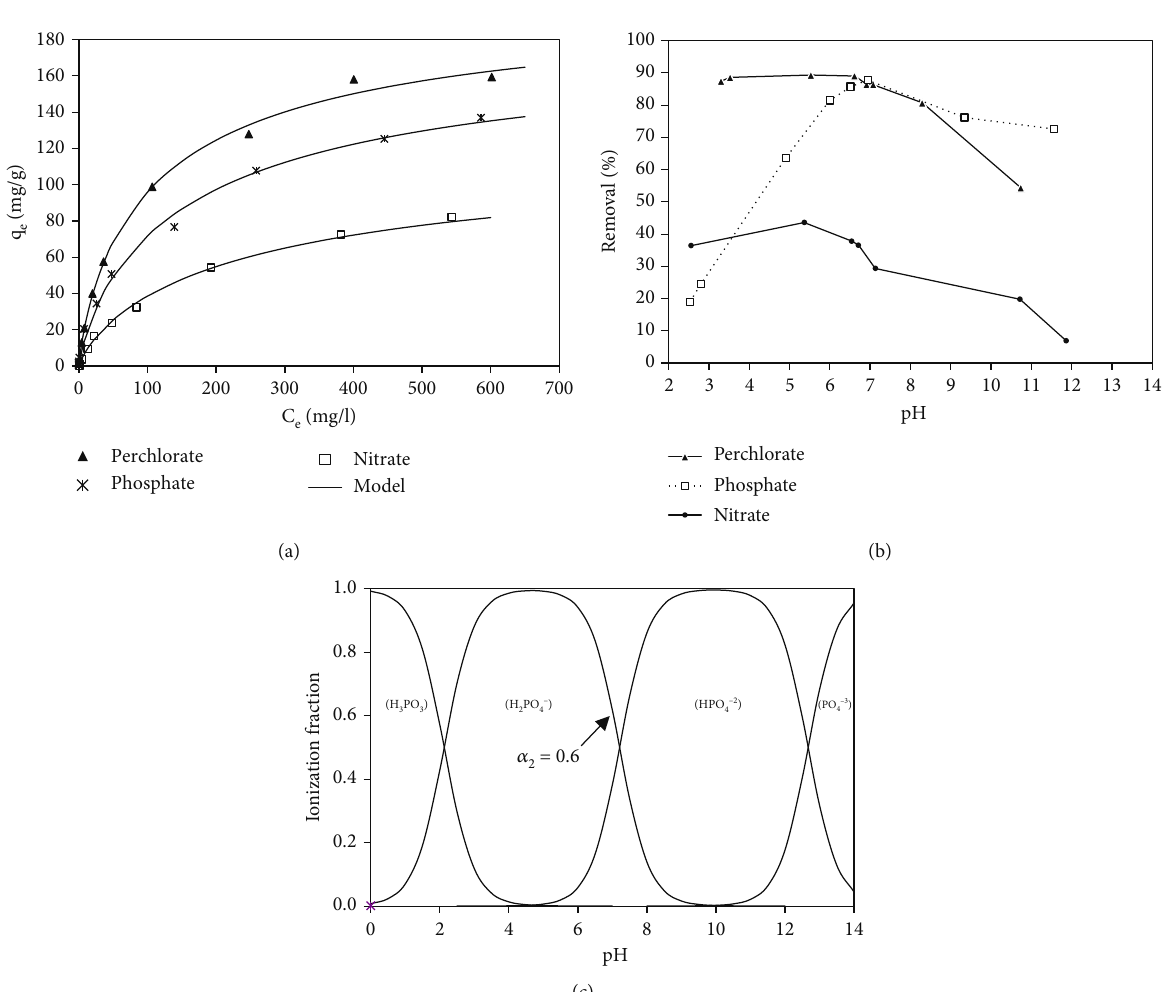
−  = 30 mg/L; initial ½ 4 PO 4- and HPO 42- at a ratio of 1.0:0.6, respectively. 2